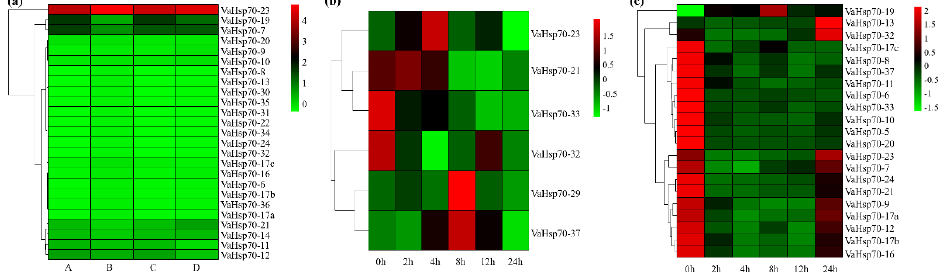
Figure 7. Expression of VaHsp70 leaves in response to osmotic and cold stress in V. amurensis . ( a ) Transcription data came from public transcriptome data PRJNA549981. A, expression of VaHsp70 under no osmotic stress. B, expression of VaHsp70 under osmotic stress for 12 h. C, expression of VaHsp70 under no cold stress. D, expression of VaHsp70 under cold stress for 12 h. ( b ) Expression of VaHsp70 in response to osmotic treatments. Horizontal axis means hours after osmotic treatments by qRT-PCR. ( c ) Expression of VaHsp70 in response to cold temperatures by qRT-PCR. Horizontal axis means hours after cold treatments.